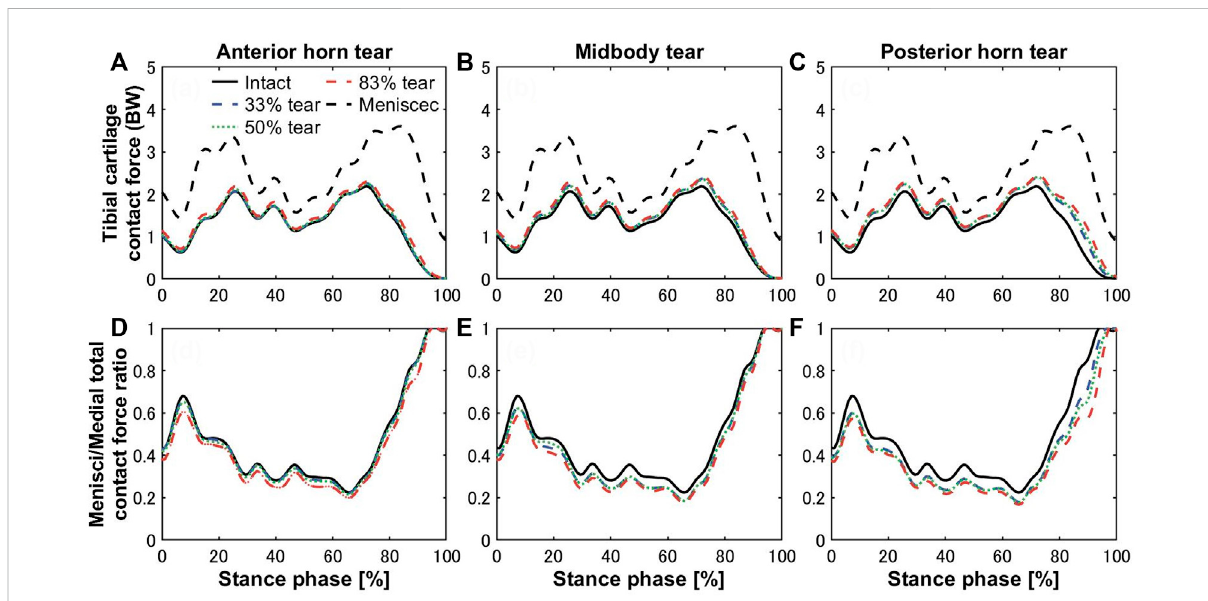
FIGURE 5 Contact forces on medial tibial cartilages of the intact knee (black solid curves) compared with total meniscectomy (black dashed curves) and (A) anterior horn, (B) midbody, and (C) posterior horn tears with widths of 33% (blue dashed curve), 50% (green dotted curve), and 83% (red dashed curve) during the stance phase of the gait cycle. The lower panels show the ratios of the medial meniscal contact forces to total knee joint contact forces on the medial side with tears in the (D) anterior horn, (E) midbody, and (F) posterior